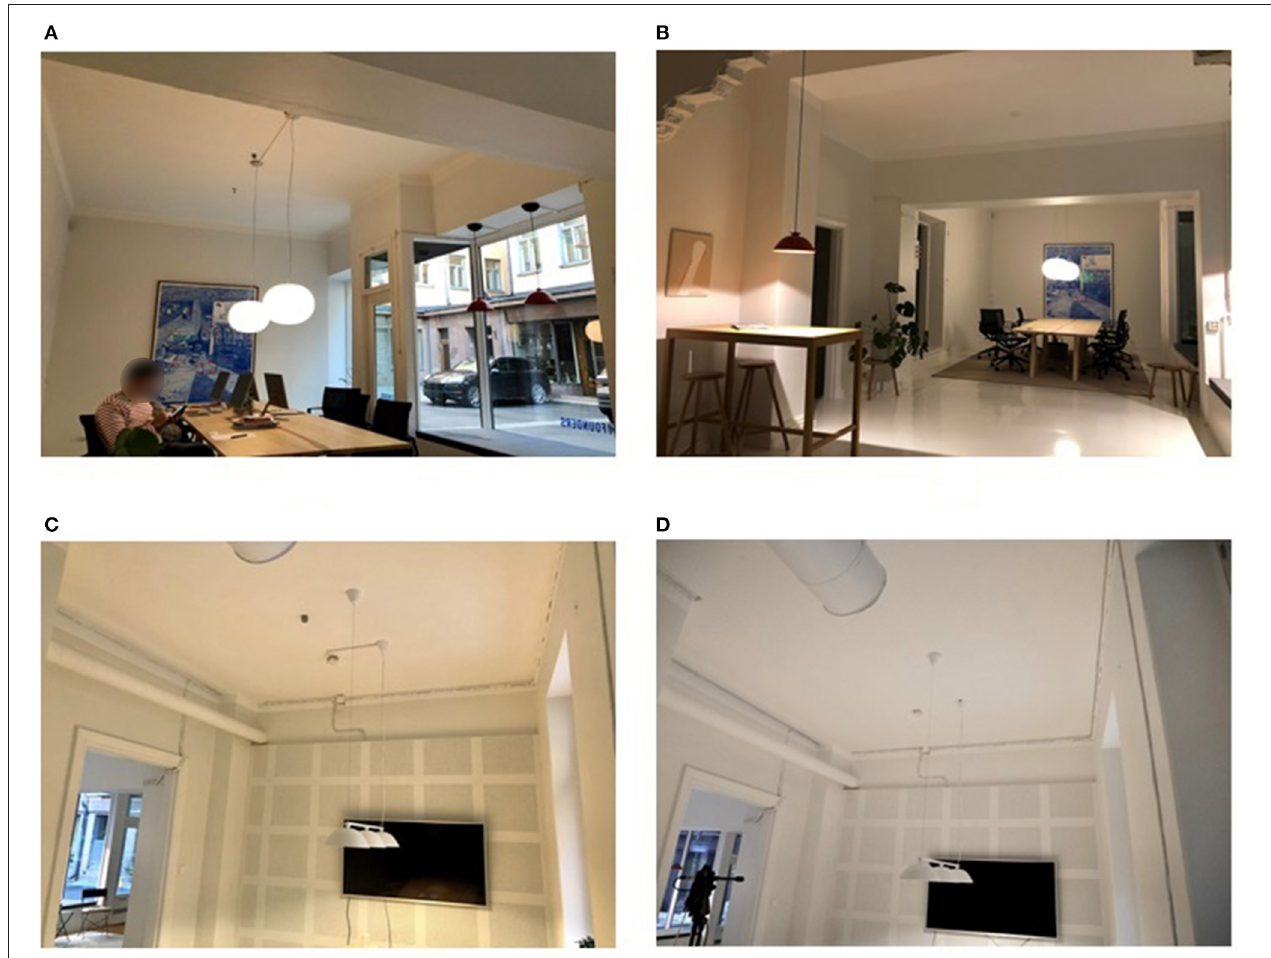
FIGURE 3 | The common office space of Co-founders before (A) and after (B) the installation of acoustic materials; and the meeting of Co-founders before (C) and after (D) the installation of acoustic